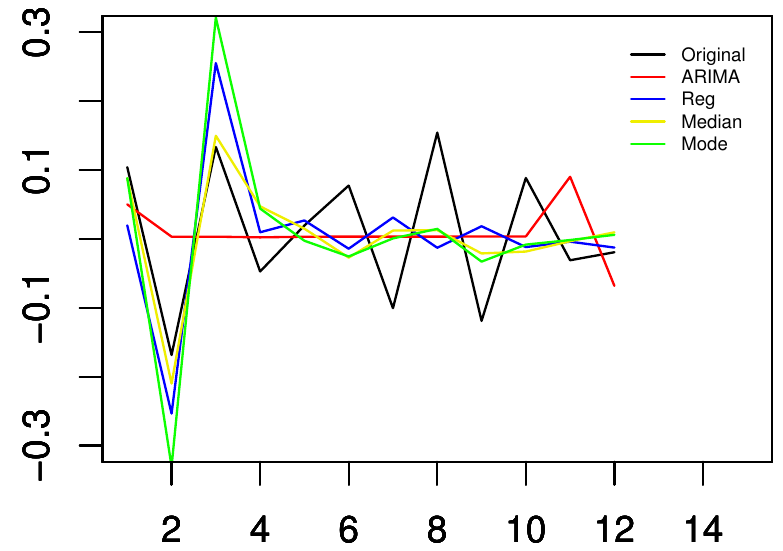
Figure 8. The curves of the true value, FNR model, FCQ model, FCM model, and ARIMA